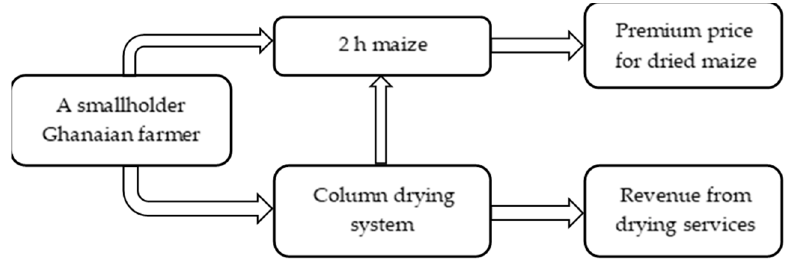
Figure 4. Schematic description of the model scenario considered in the